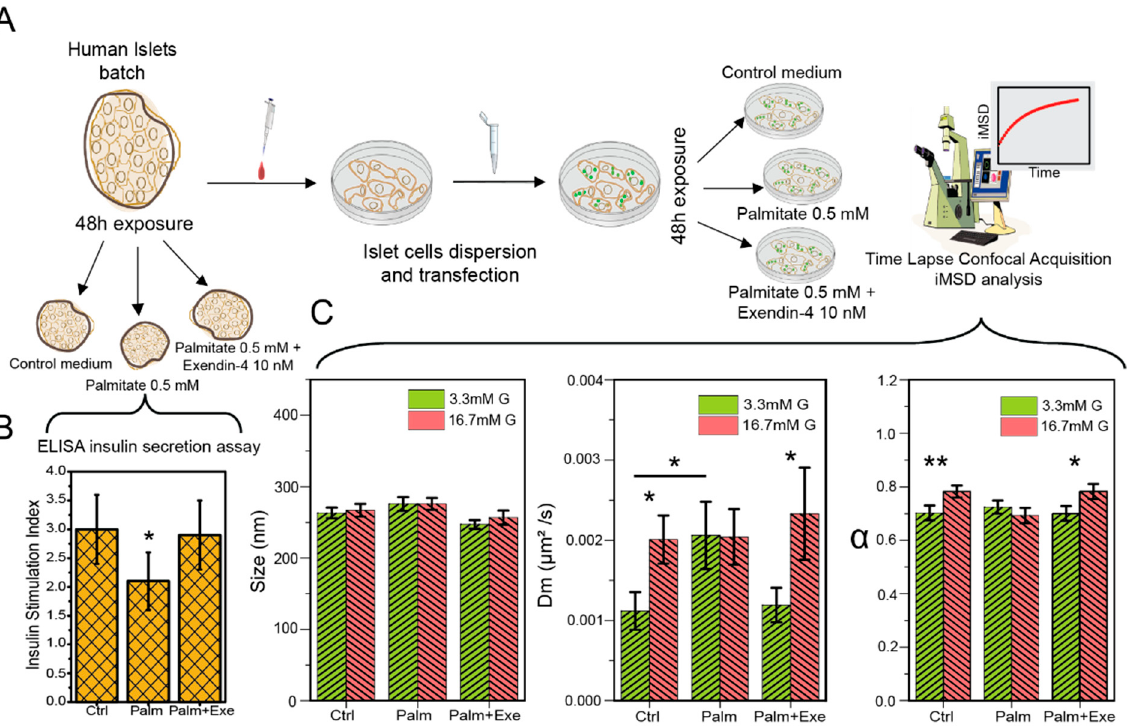
Figure 2. The effect of Exendin-4 on palmitate-treated dispersed human β -cells. ( A ) Workflow of the experimental procedure. Isolated human Langerhans islets were exposed for 48 h to control medium (Ctrl), 0.5 mM Palm and 0.5 mM Palm + 10 nM Exe-4 and then tested for insulin secretion. In a parallel set of experiments, HI from the same donor were dissociated and transfected with Syncollin-EGFP plasmid in order to label ISGs. Dispersed cells were exposed for 48 h to conditions described above, then fluorescently labeled ISGs’ structural and dynamic properties were evaluated in a confocal microscope experiment. ( B ) Insulin stimulation index measured with ELISA kit assay for intact islets exposed to control medium, Palm and Palm + Exe ‐ 4. (* p < 0.05). ( C ) iMSD derived parameters (size, D m and α ) were measured in a low (3.3 mM) glucose concentration and after stimulation with high (16.7 mM) glucose in Ctrl, Palm and Palm + Ex ‐ 4 treated cells. Data represented as Mean ± SE (* p < 0.05, ** p < 0.01— t ‐ test). ‘Ctrl’: control medium; ‘Palm’: 0.5 mM palmitate; ‘Palm + Exe’: 0.5 mM palmitate + 10 nM Exendin ‐ 4.